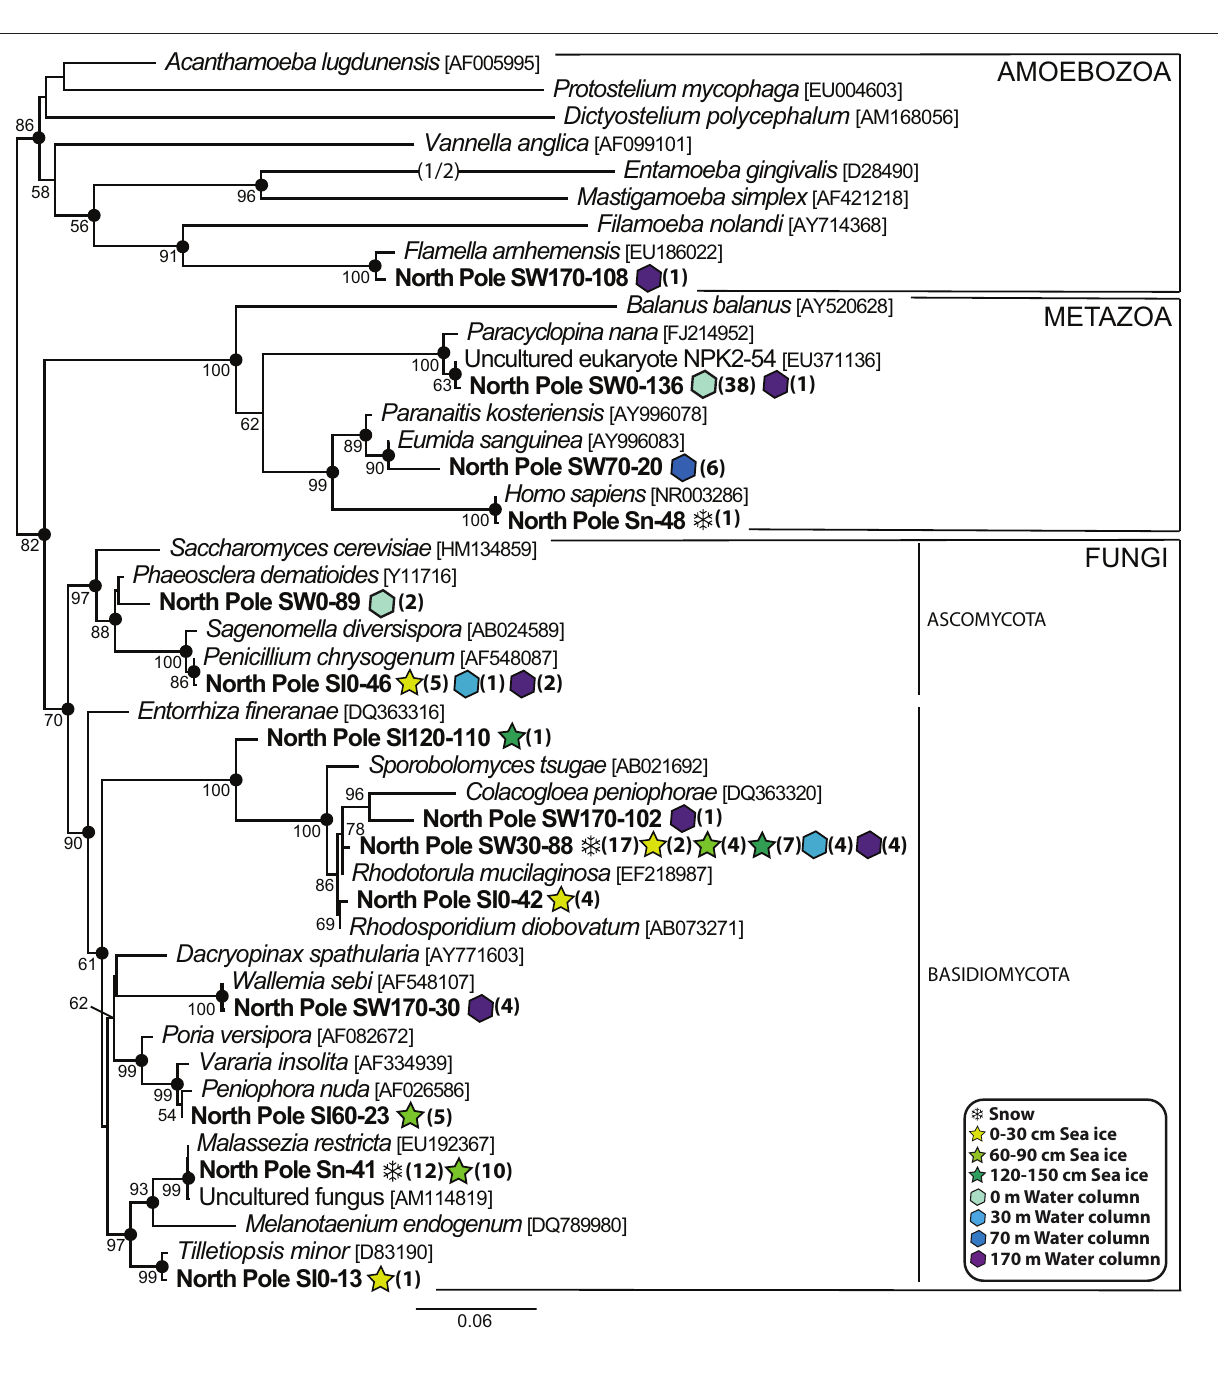
Figure 7 | Maximum likelihood phylogenetic tree of diverse animal, fungal and amoebozoan